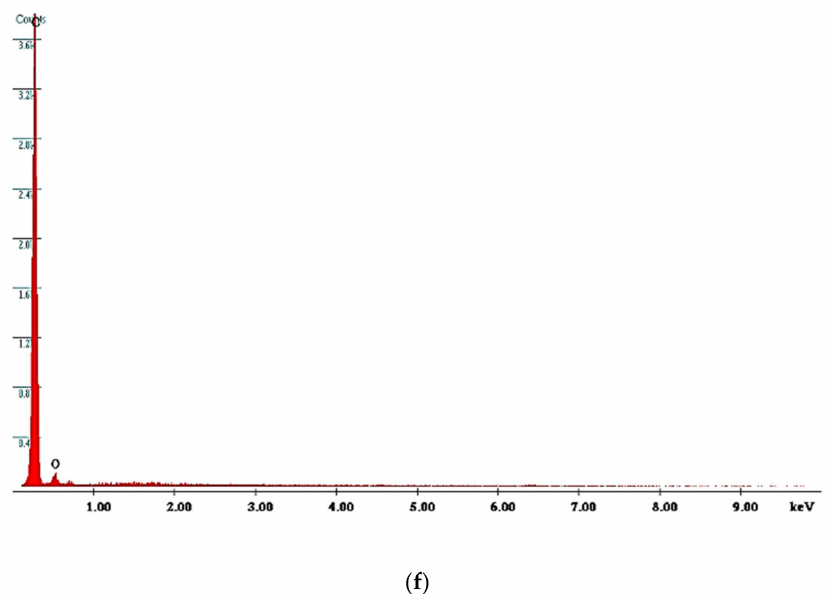
Figure 19. SEM track analysis for abrasive diamond powder (1–2 µ m) with 0.2 N load for AISI 52100 ball: ( a ) track on the ball, ( b ) track on the ball detail analyzed, ( c ) embedded diamond particle dimension on the central mark, ( d ) embedded diamond particle dimension on the sides, ( e ) EDS spectrum in the Z4 zone indicating diamond particle, ( f ) EDS spectrum in the Z6 zone indicating diamond